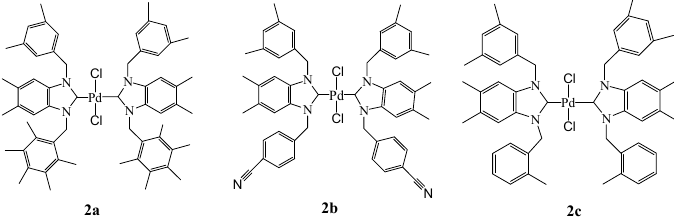
Figure 2. Structure of bis-NHC-palladium Complexes 2a – c .